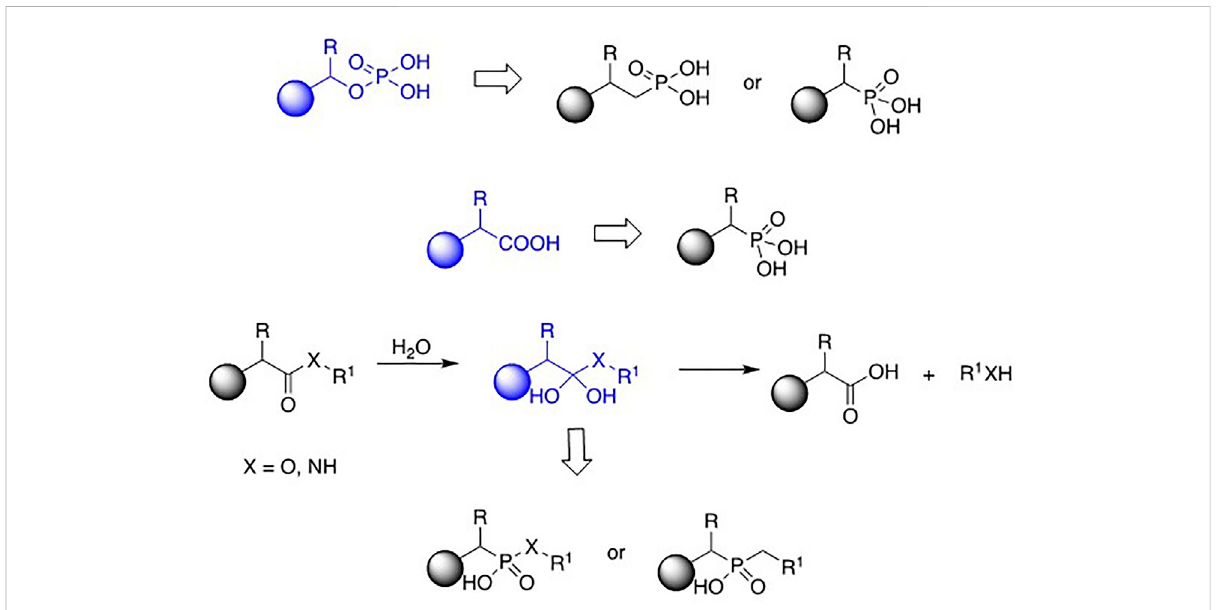
FIGURE 1 Phosphonic acids as analogues of phosphates, amino acids and